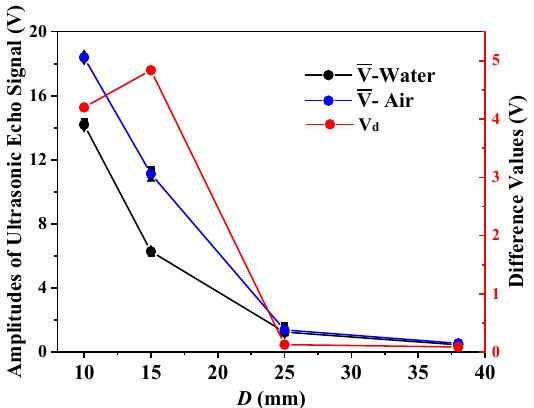
Figure 3. Results comparison diagram with different diameters.